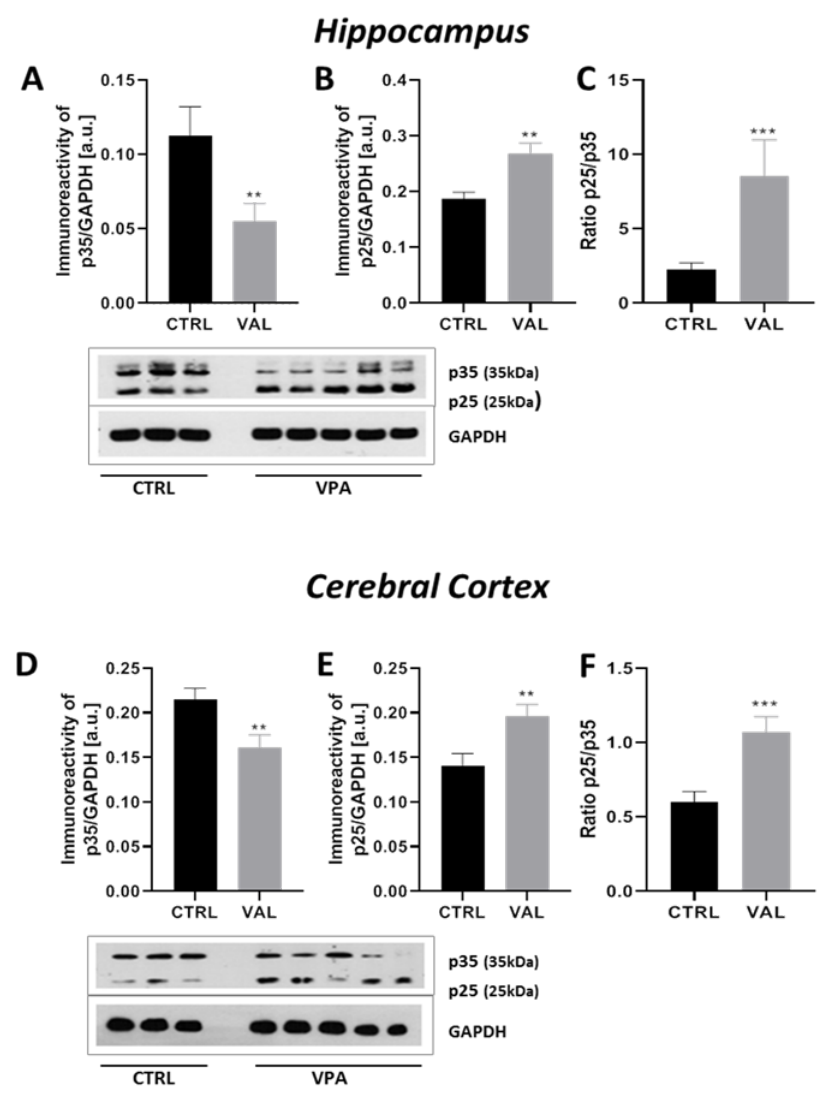
Figure 12. The effect of prenatal exposure to VPA on the calpain-dependent activation of CDK5 kinase in the rat brain. Immunoreactivity of p35 and its degradation product p25 were determined using Western blot analysis. Densitometric analysis and representative pictures of p35 and p25 in the hippocampus ( A , B ) and cerebral cortex ( D , E ) were shown. Results were normalized to GAPDH levels. Additionally, the ratio of p25/p35 in the hippocampus ( C ) and cerebral cortex ( F ) were measured. Data represent the means ± S.E.M. from n = (11–14) independent experiments in both the hippocampus and cerebral cortex: ( A ) n = 11 (CTRL), n = 14 (VPA); ( B ) n = 11 (CTRL), n = 14 (VPA); ( C ) n = 11 (CTRL), n = 14 (VPA); ( D ) n = 11 (CTRL), n = 14 (VPA); ( E ) n = 11 (CTRL), n = 14 (VPA); ( F ) n = 11 (CTRL), n = 14 (VPA). ** p < 0.01, *** p < 0.001, vs. control.